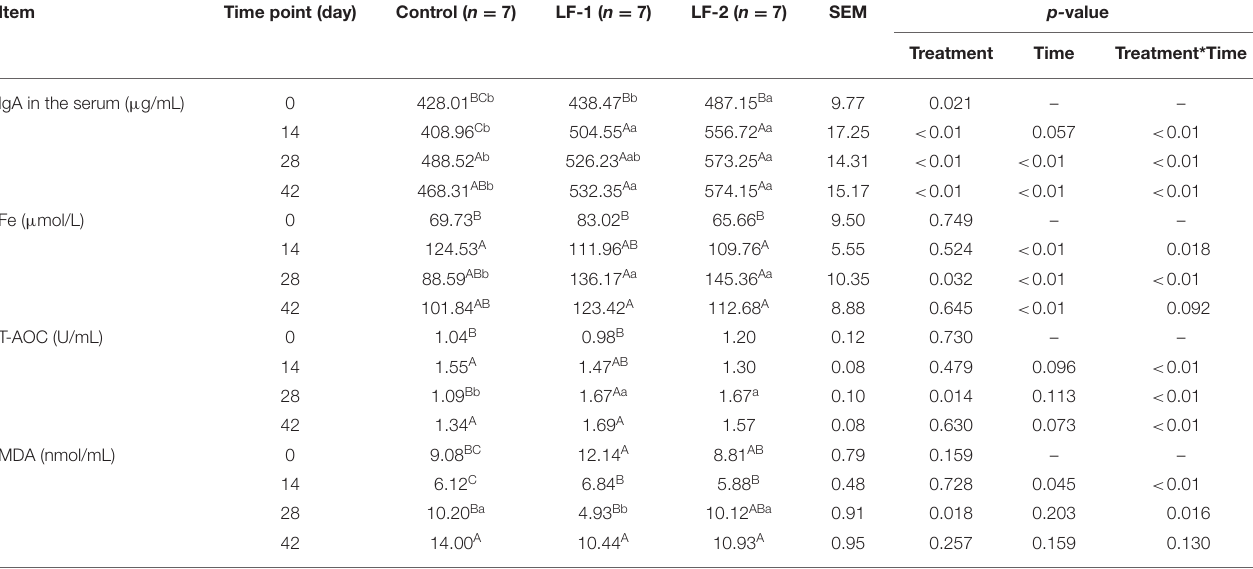
TABLE 2 | The effect of supplementation of BLFc at the rate of 100 mg/kg/day (LF-1) or 200 mg/kg/day (LF-2) on IgA, Fe, total antioxidant content (T-AOC), and Malondialdehyde (MDA) in the serum of dairy